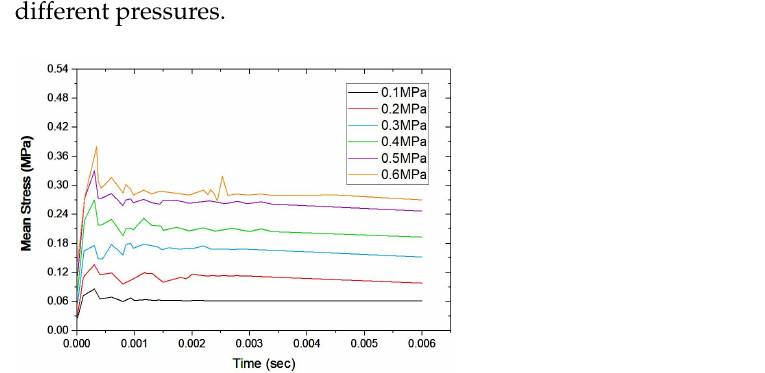
Figure 8. Mean stress of the bowl.